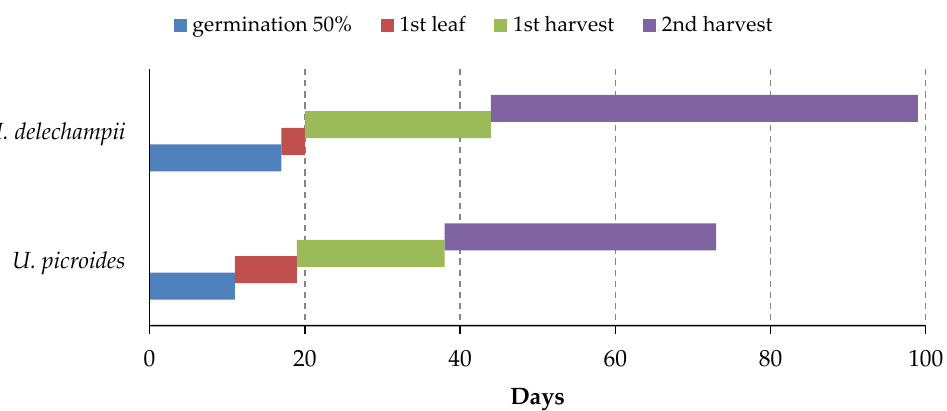
Figure 1. Crop cycle of U. delechampii and U. picroides grown in a floating system.